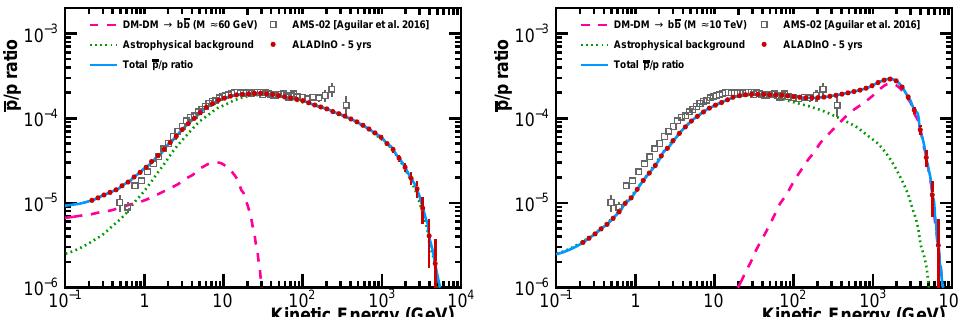
Figure 5. Antiproton-to-proton ratio (blue line) as a function of kinetic energy. The green dotted lines represent the contribution according to standard calculations for the astrophysical background. The two scenarios represent the contribution of an additional component from 60GeV ( left ) and 10TeV ( right ) mass DM particles annihilating in bb [108] (dashed pink line). In both scenarios, projections for ALADInO in 5 years of observation time are shown (red points) and compared with the recent measurements by AMS-02[47] (empty squares). Figure readapted from[96] under license CC BY